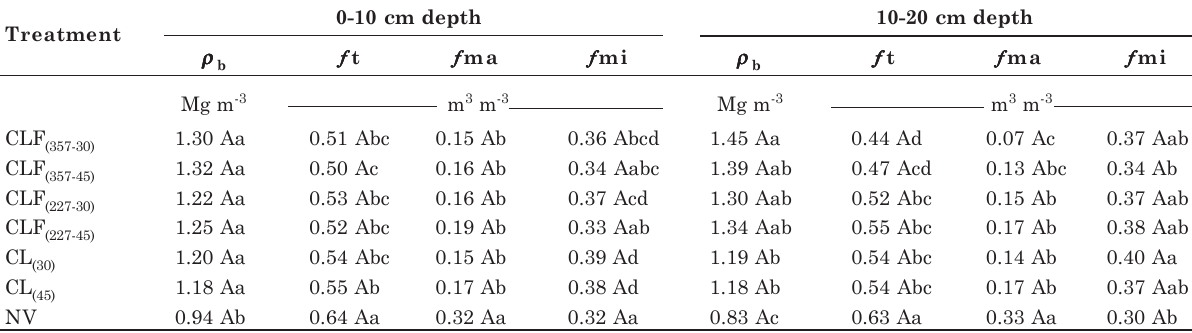
Table 1. Soil bulk density ( ρρρρρ b ), total porosity ( ƒƒƒƒƒ t), macroporosity ( ƒƒƒƒƒ ma) and microporosity ( ƒƒƒƒƒ mi) at the soil depths and in the treatments studied